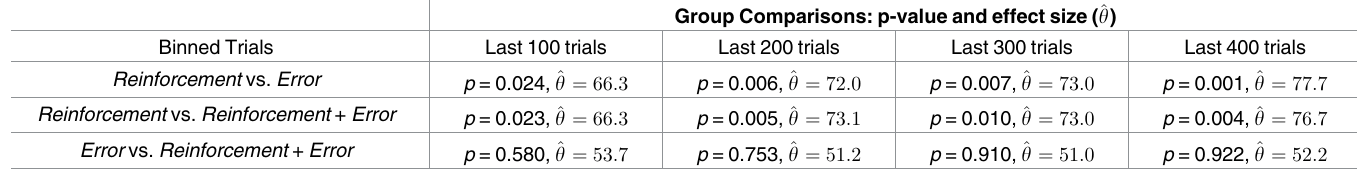
Table 1. Group comparisons, p-values and effect sizes ( ^ y ), were robust to whether the last 100, 200, 300 and 400 trials were averagedtogether. Group Comparisons: p-value and effect size ( ^ y ) Binned Trials Reinforcement vs.